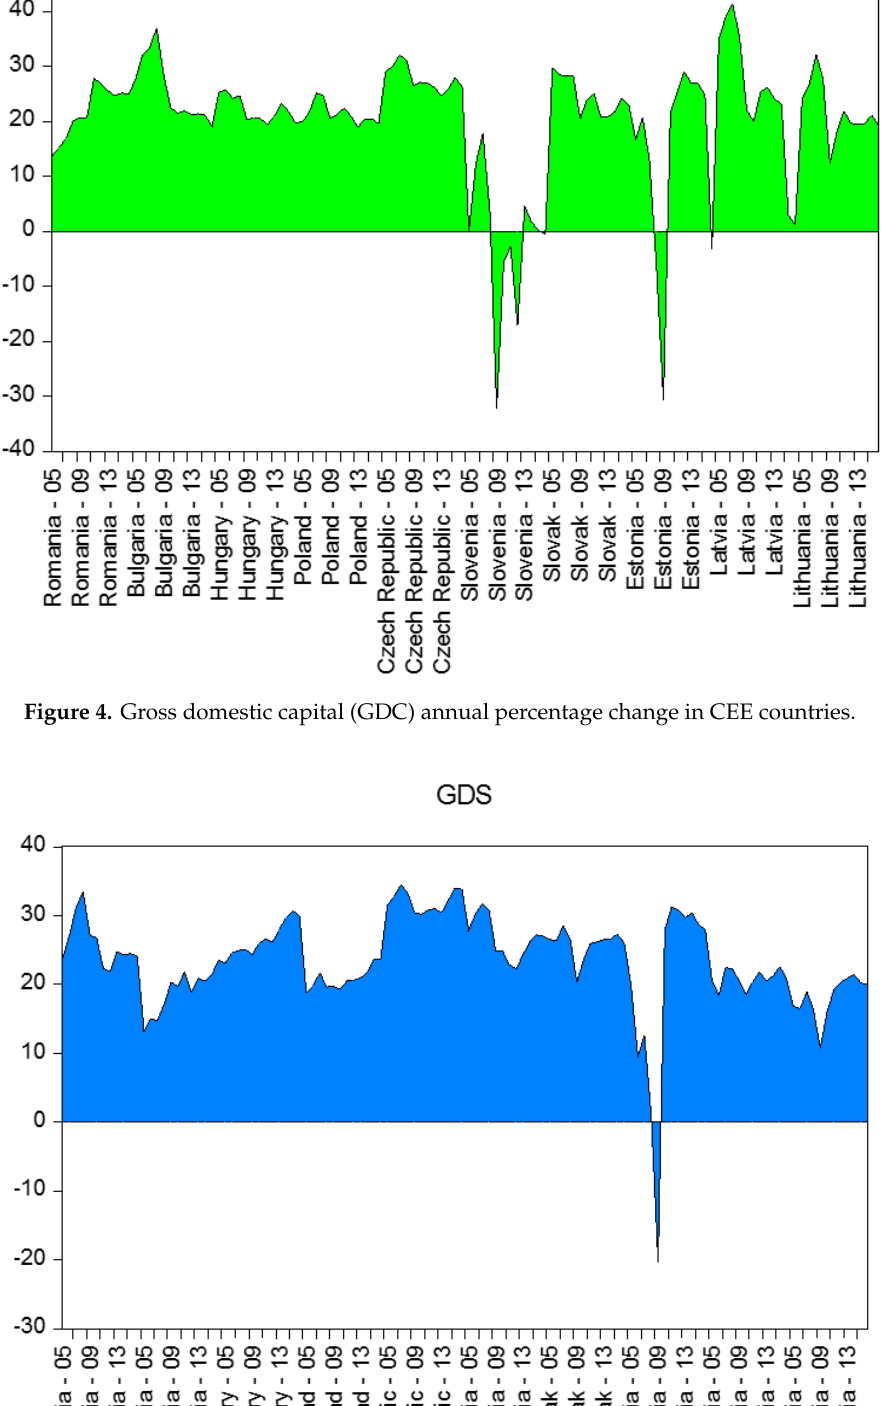
Figure 3. Gross domestic product purchasing power parity (GDP_PPP) annual percentage change in CEE countries.